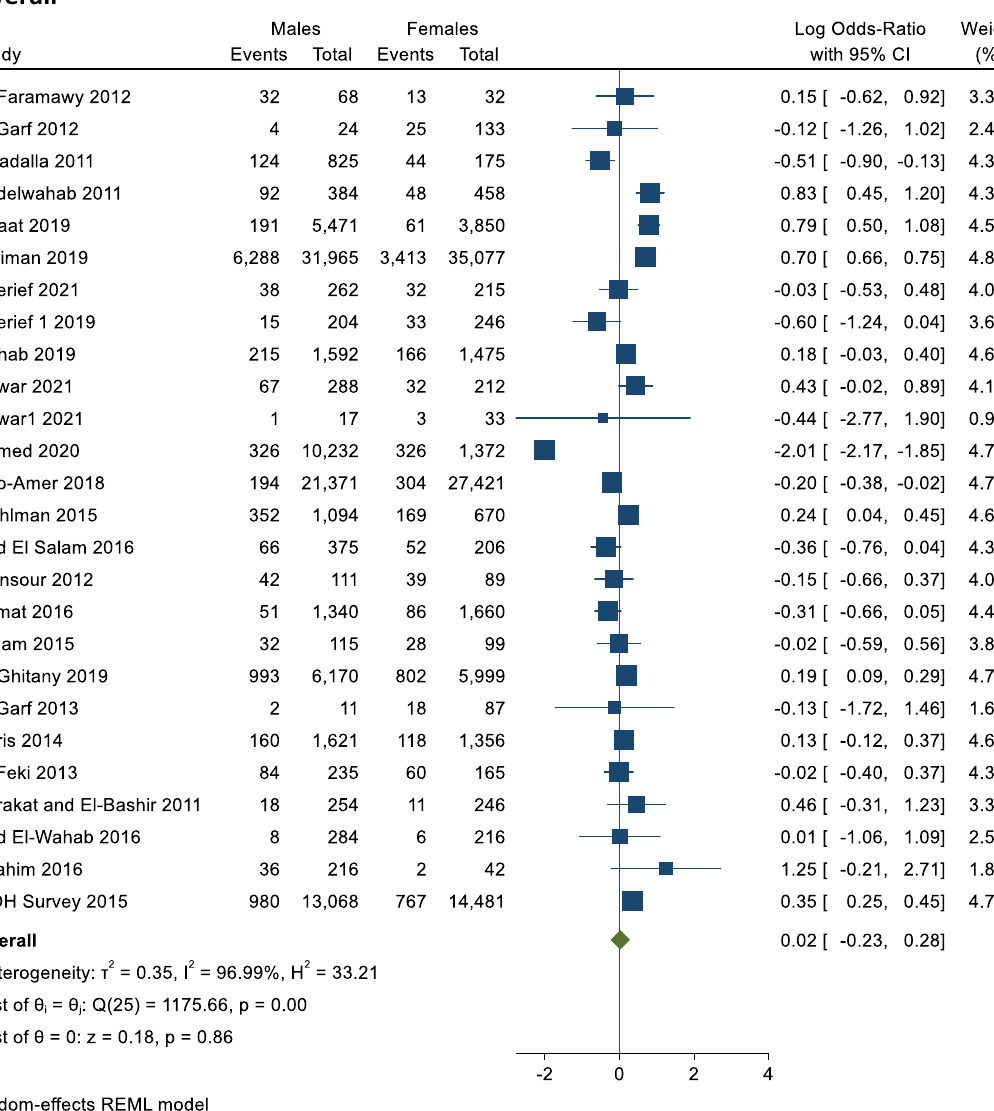
Figure 2. Forest plot of seroprevalence of HCV antibodies in males and females. There is no significant difference in seroprevalence of HCV antibodies between males and